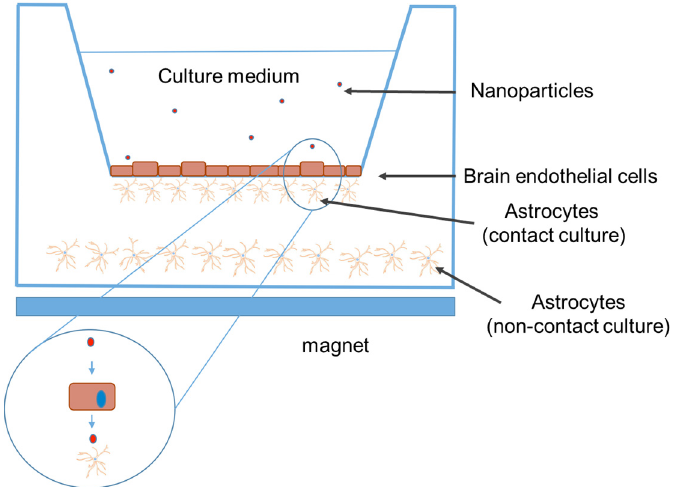
Figure 3. Cellular model for checking the passage of drugs or NPs across the BBB. The Transwell filter consists of a porous membrane support submerged in a culture medium. Two different Transwell co-culture modes exist: non-contact and contact culture. In non-contact culture, the cells (for instance, brain endothelial cells and astrocytes) are co-cultured in two different compartments (insert membrane in well). In contact culture, astrocytes are first seeded onto the abluminal side of the inverted Transwell filter, and after adhering, the filter is flipped back, and the astrocytes are cultured for 2 days. At the end of the second day, brain cells are seeded onto the luminal side of the Transwell filter and co-cultured with astrocytes for an additional 3–4 days. The number of NPs is determined in both compartments. Superparamagnetic IONs (SPIONs) are depicted as red dots. The passage through the BBB model can be mediated by the effect of a magnet located underneath the